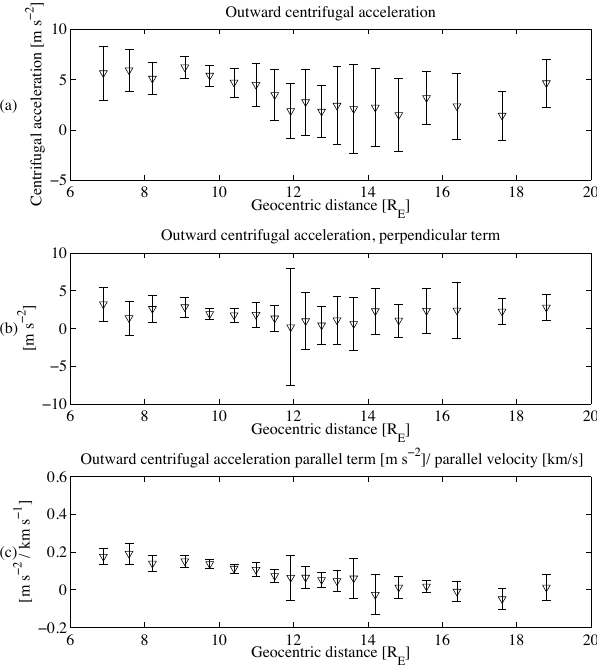
Fig. 2. Panel (a) shows the distribution of the centrifugal accelera- tion as function of the geocentric distance. Panel (b) shows the aver- age centrifugal acceleration due to the perpendicular term [ms − 2 ]. Panel (c) shows the average of the parallel centrifugal acceleration term divided by the parallel velocity [ms − 2 /(kms − 1 )]. The x-axis show the geocentric distance [ R E ]. Error bars indicate 95% confi- dence level for normal distributed data, based on both variance of orbit average values and variance of all measurement